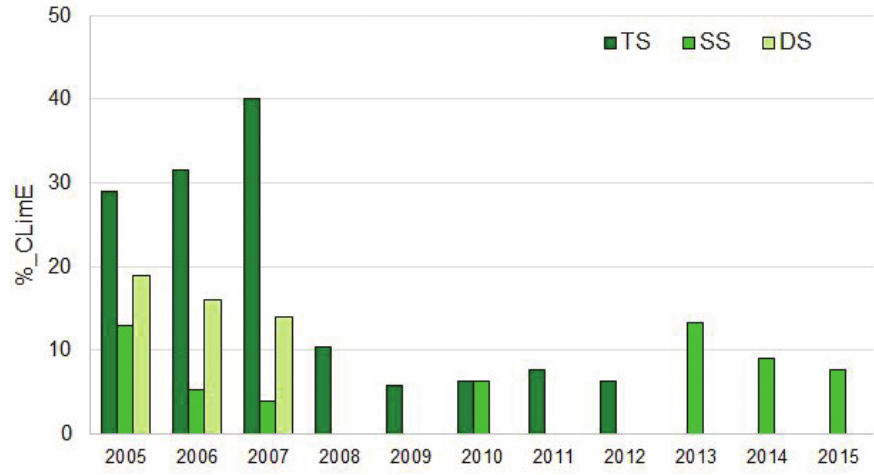
Figure 7. Percentage of individual exceedances of the critical limit (CLimE) per year in the topsoil solu- tion (TS), subsoil solution (SS) and deep soil solution (DS) from 2005 to 2015.